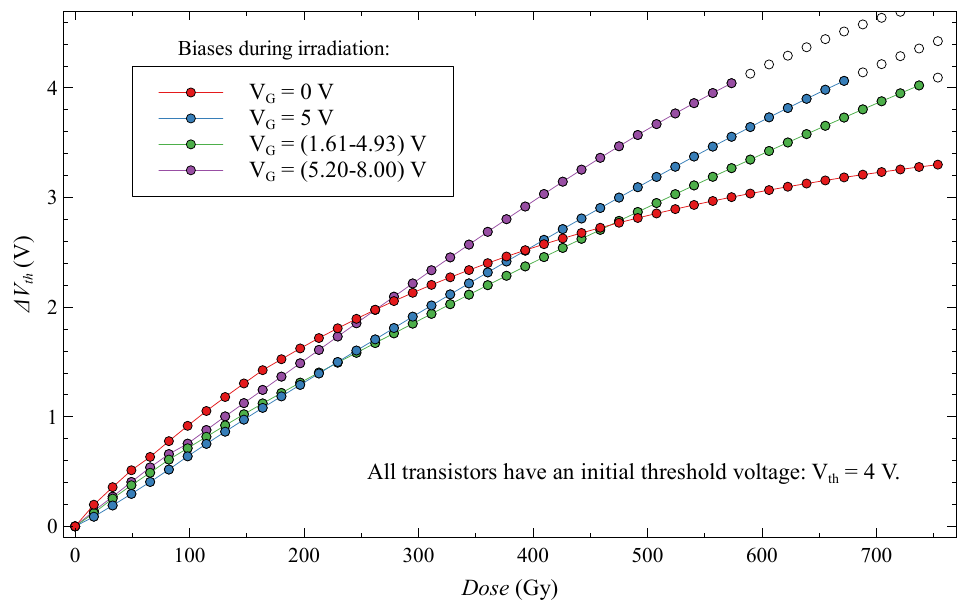
Figure 26. The EPADs with best dosimetric characteristics in all subgroups. White data dots are representing the values after the “four-volt